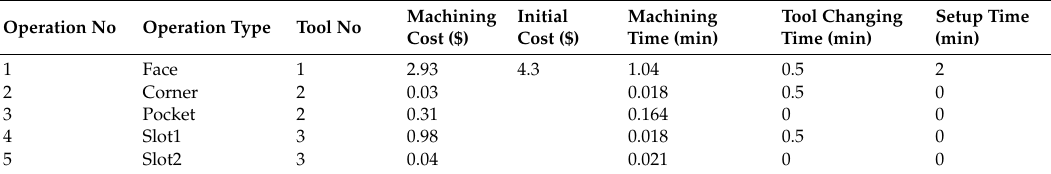
Table 10. Results by using optimum parameters.